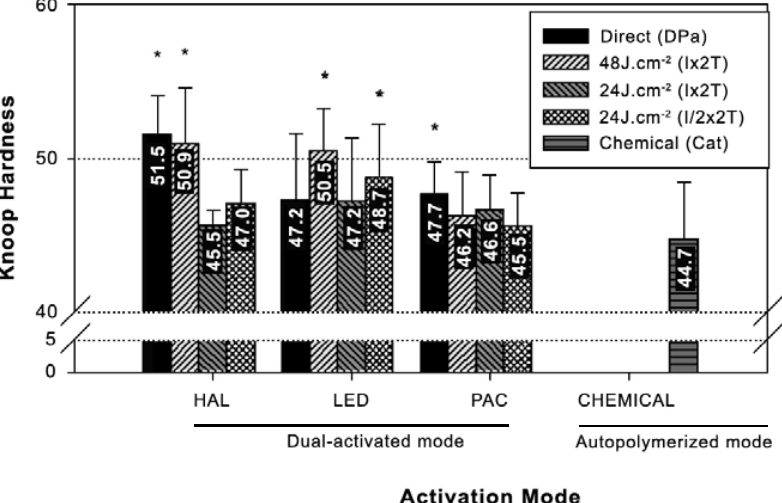
FIGURE 1- KHN means at 100- µ m depth for each light-curing unit (n=10) according to the different activation modes. Asterisk represents means that are significantly higher than the control (chemical activation